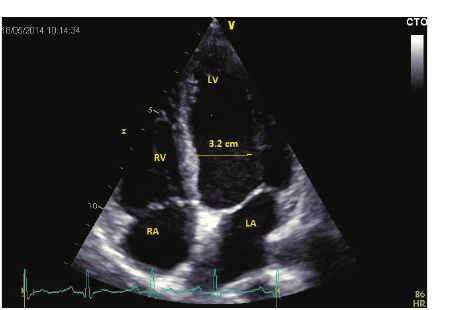
Figure 3: Transthoracic two-dimensional echocardiography show- ing normal sized ventricular cavities (LV dimension in systole is 3.2 cm) and normal heart valves. LV: left ventricle, LA: left atrium, RA: right atrium, and RV: right ventricle.